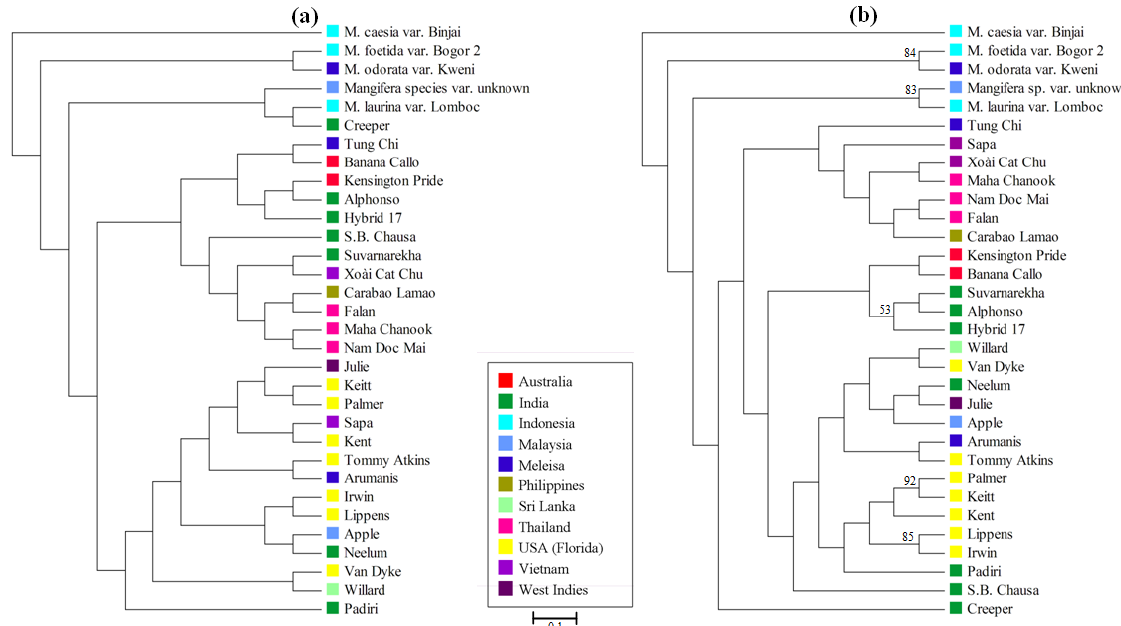
Figure 1. Neighbor-joining dendrogram, rooted on the mid-point, using Cavalli-Sforza distance based on ( a ) 25 EST-SSR markers and ( b ) 25 EST-SSR plus 11 SSR markers. Scale bar indicates branch length. Bootstrap values greater than 50% are